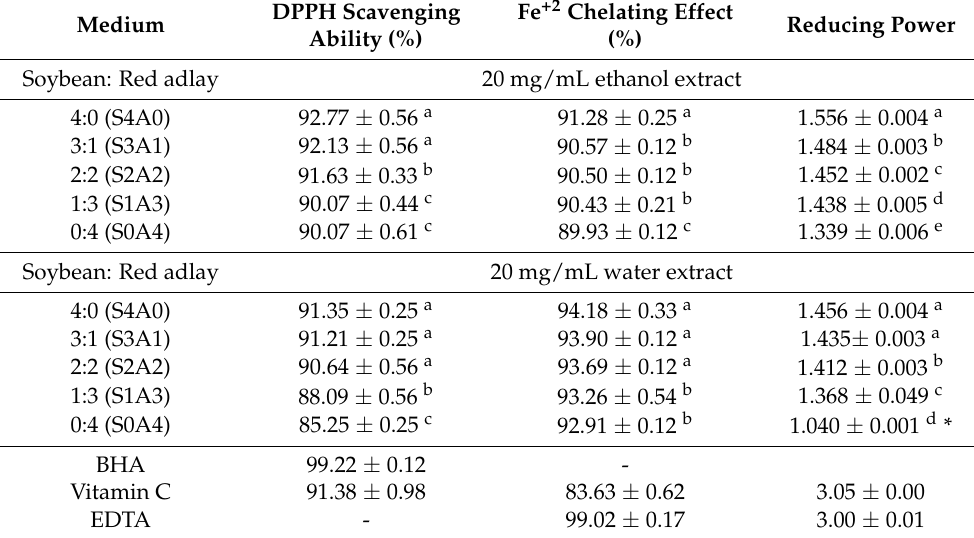
Table 3. Effects of different mixed media on antioxidant activities of 20 mg/mL ethanol and water extracts of mycelial products obtained by white truffle solid-state